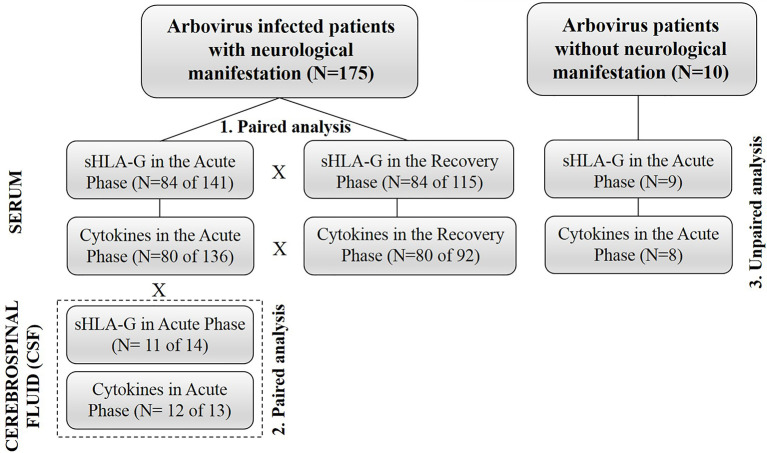
Flowchart summarizing major strategies used in the design of the study.